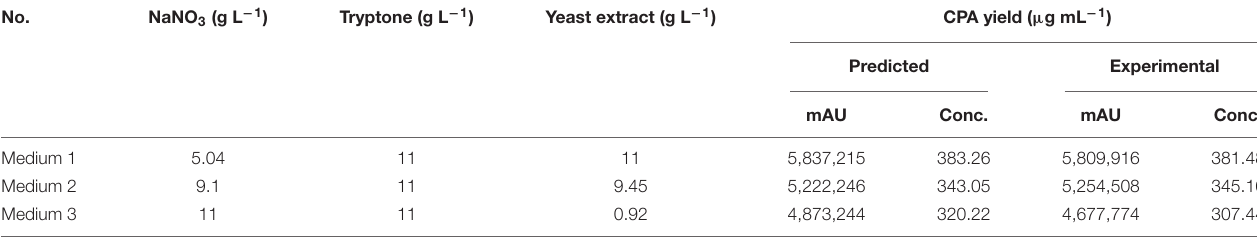
TABLE 7 | Model validation experiments for cyclopiazonic acid (CPA) production from Penicillium commune KACC 45973. No.